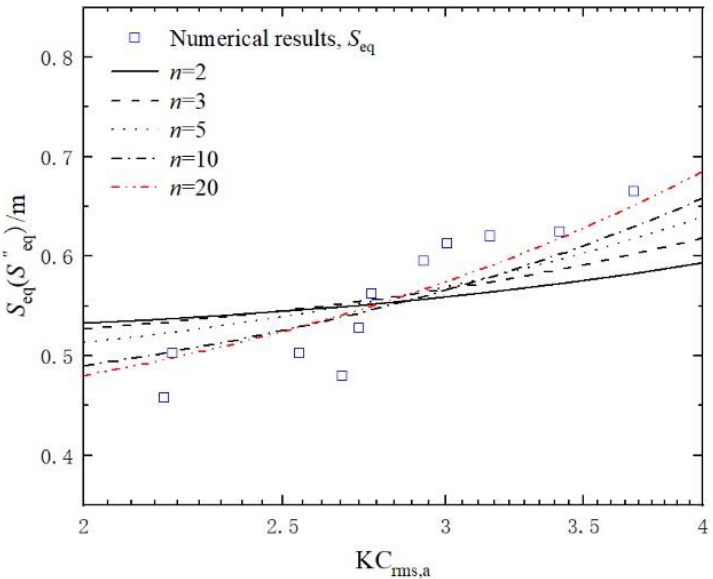
Figure 11. Comparison of S eq between the predicted results from the revised stochastic model and the numerical results of the present study. the numerical results of the present